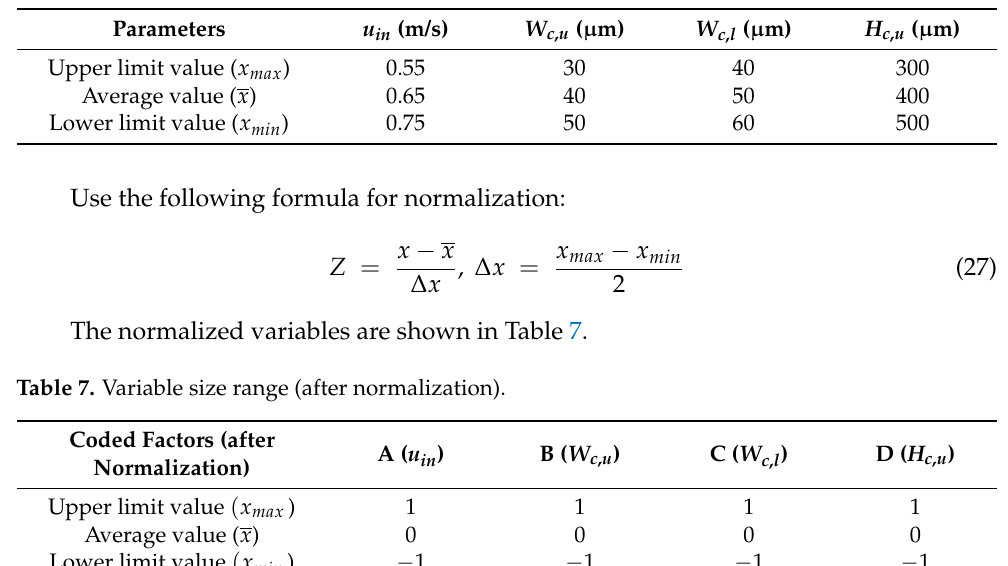
Table 6. Variable size range.